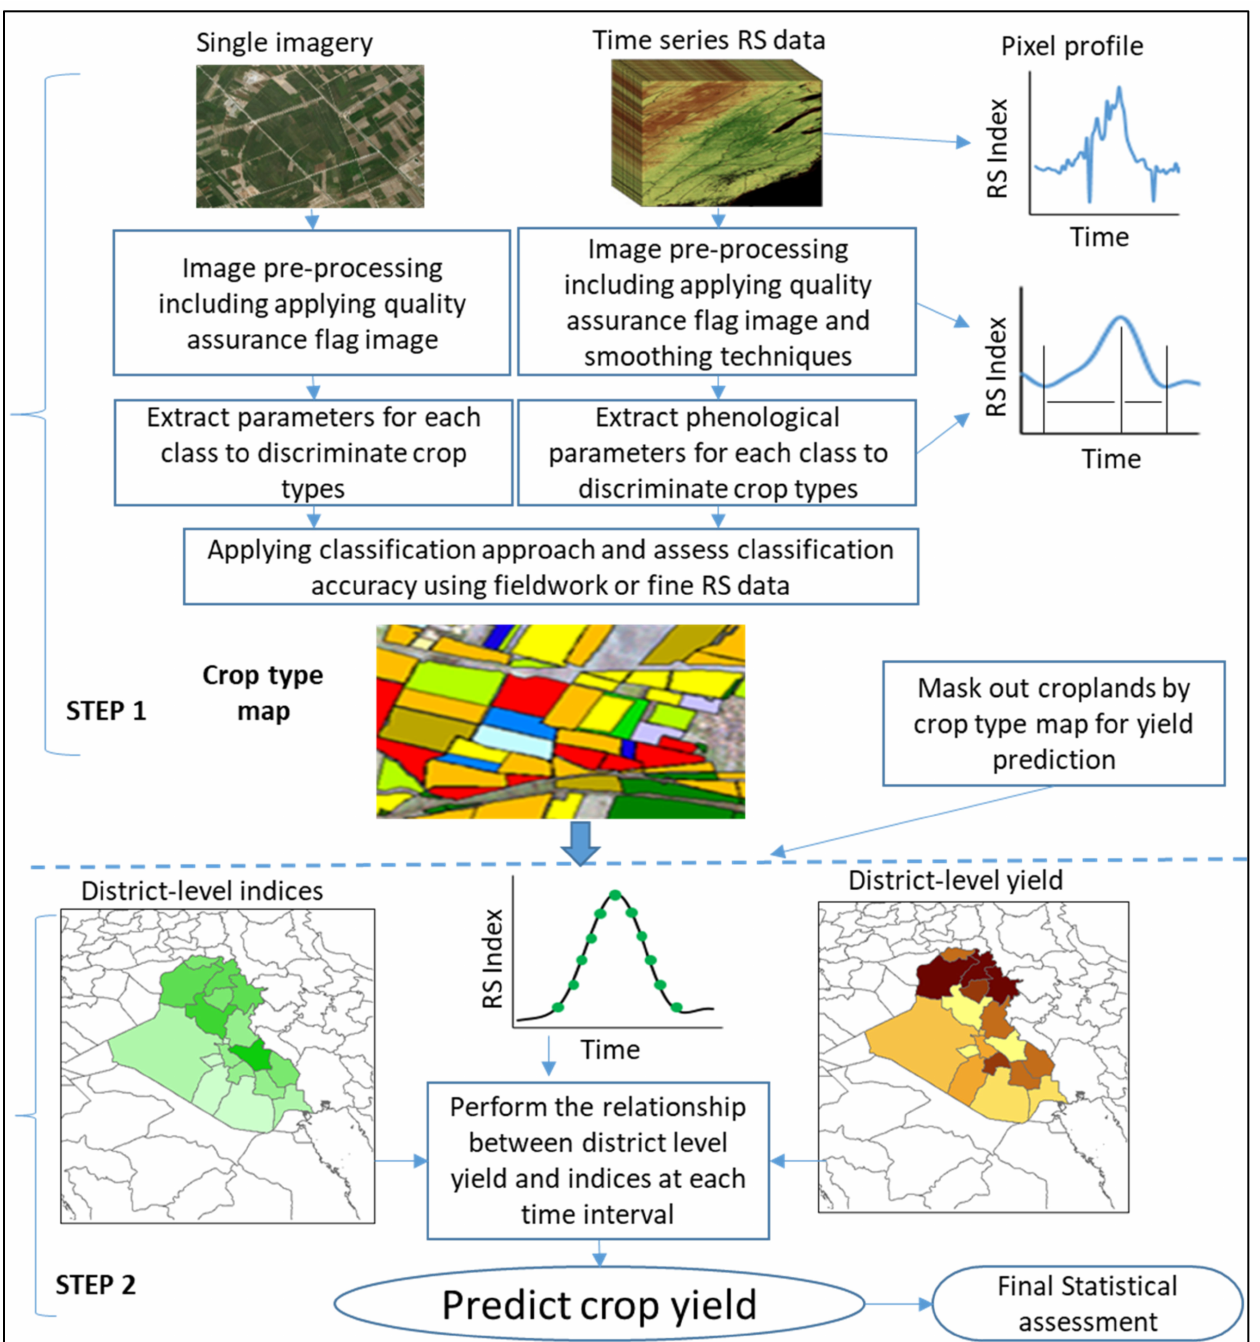
Figure 2. Schematic diagram illustrating the general methodology for using RS data to forecast crop yield. Step 1: processing steps typically applied to remote sensing data to predict crop type and Step 2: processing steps typically applied to forecast crop